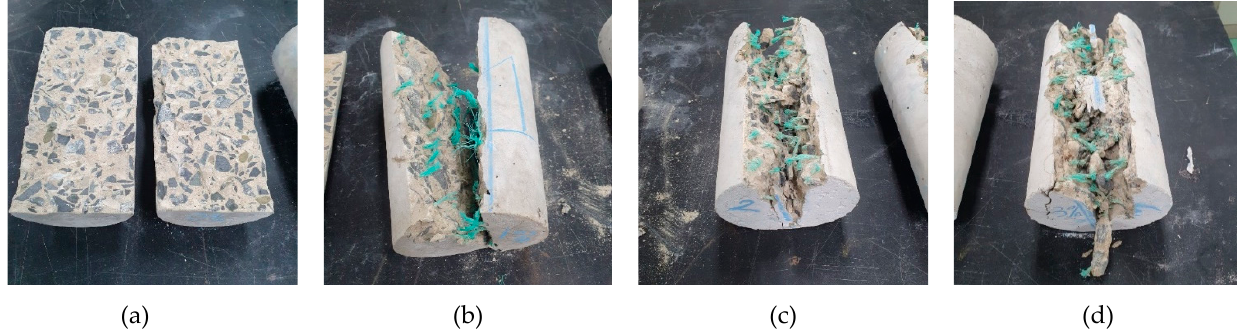
Figure 7. Failed cylindrical concrete samples from the splitting tensile strength test: ( a ) Plain concrete; ( b ) 1% WFN fiber-reinforced concrete; ( c ) 2% WFN fiber-reinforced concrete; ( d ) 3% WFN fiber-reinforced concrete.